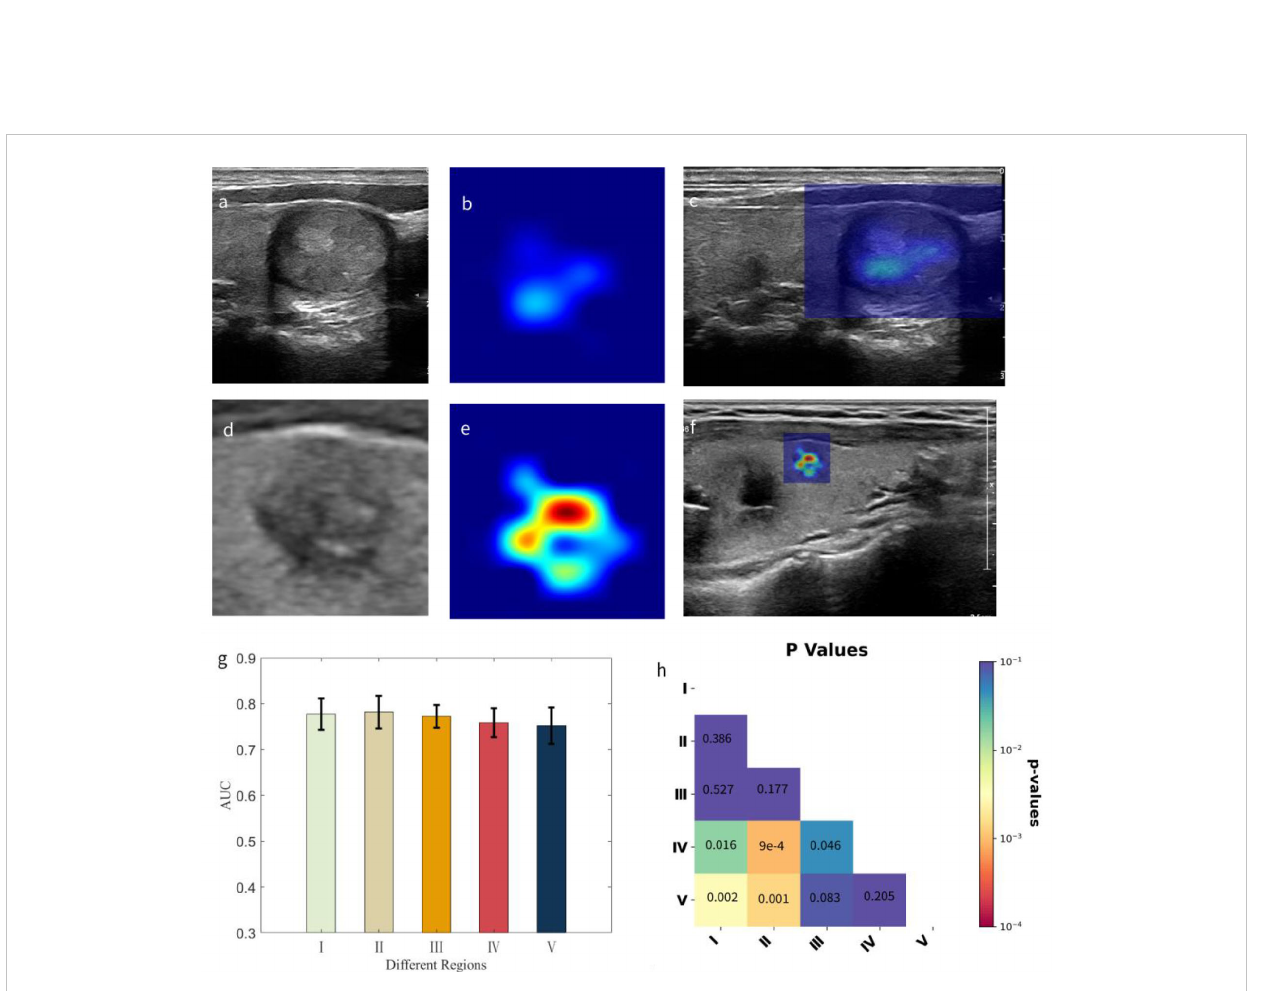
FIGURE 5 Our proposed malignancy heat map and the in fl uence of noise perturbations to fi ve different regions on classi fi cation performances. (A, D) The cropped zoomed-in images for benign and malignant nodules, respectively. (B, E) The corresponding heat maps with color temperature bounded by the predicted malignant probabilities (0.2907 vs. 0.9382) by the AI-CADx system. (C, F) The superimposed images for the corresponding nodules and heat maps. (G) Each bar representing the corresponding region is presented with the average AUC values over the fi ve subdivided malignant datasets and the standard deviations. (H) The associated p-value matrix for statistical comparisons. The smallest p-values were<0.001, and self- comparisons were omitted, as they were constant at 1. AI-CADx, arti fi cial intelligence computer-aided diagnosis; AUC, area under the